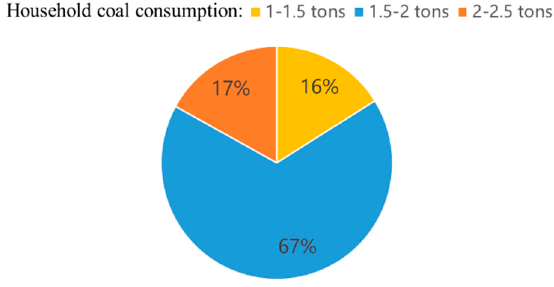
Figure 6. Distribution proportion of household coal consumption.